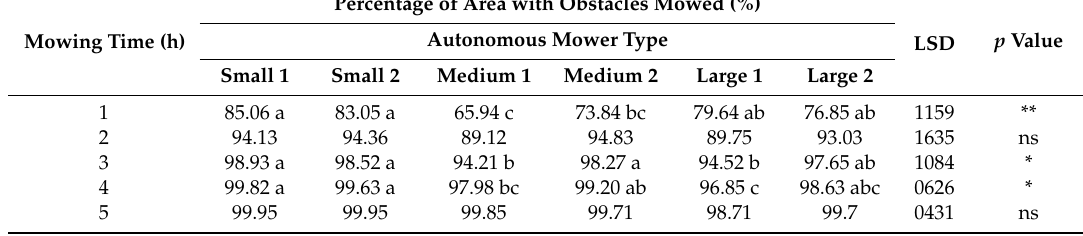
Table 2. Back-transformed mean values of the percentage of area with obstacles within Site A mowed after 1–5 h by the six di ff erent autonomous mowers.